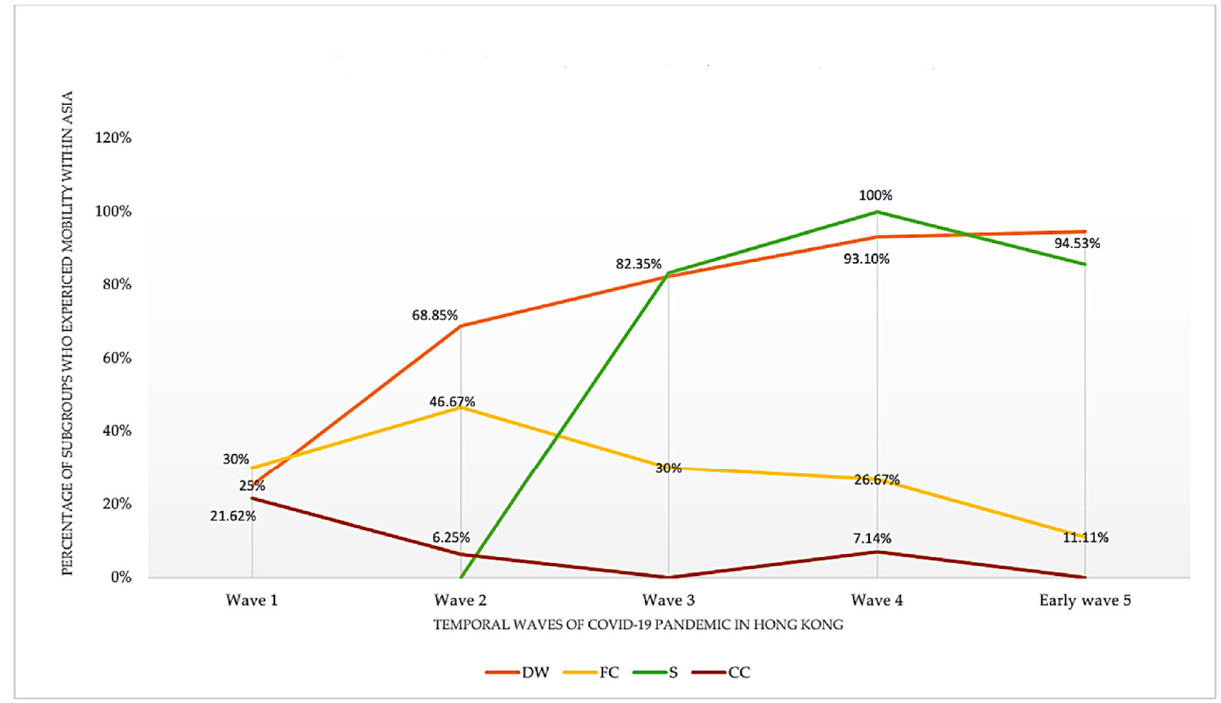
Figure 5. Study Population’s Temporal Mobility within Asia (non-Hong Kong Territory).